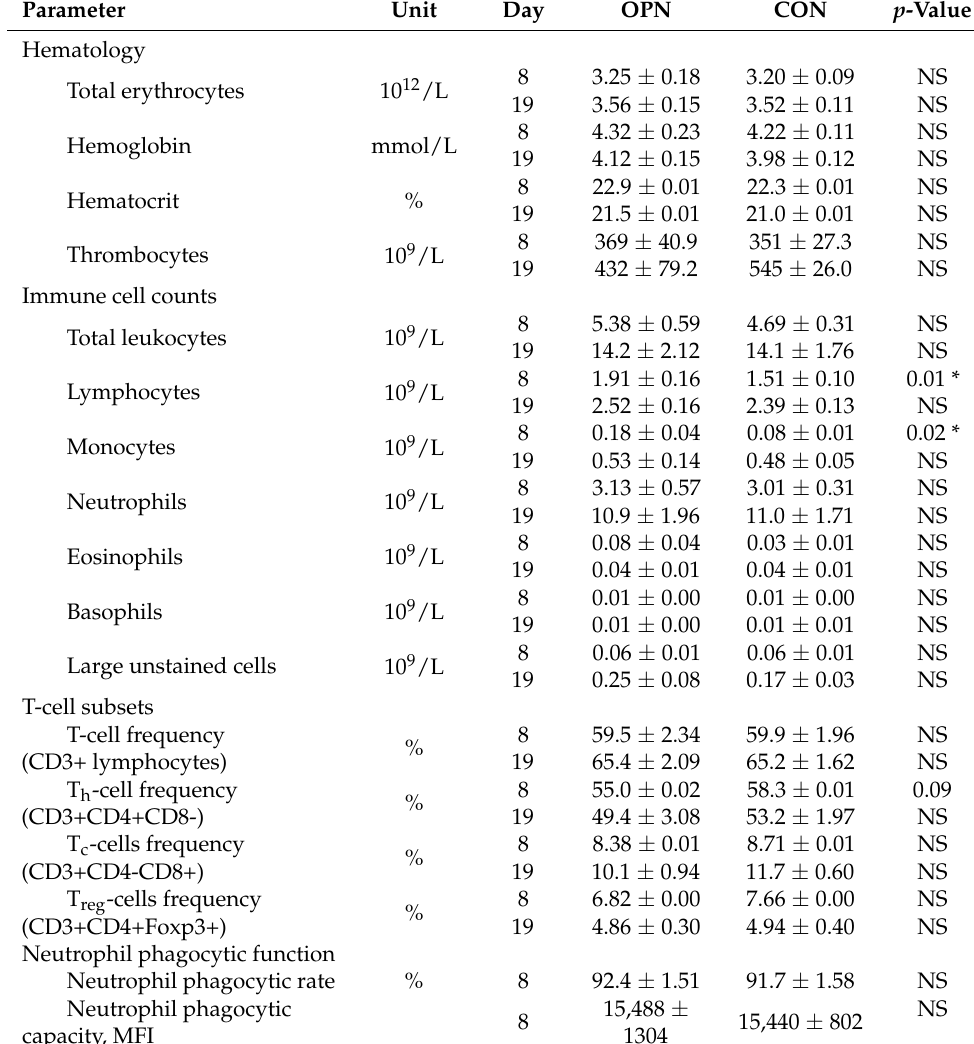
Table 3. Hematological and systemic immunity parameters of preterm pigs on Days 8 and 19. The pigs received a bovine milk diet (CON, n = 12-18) or the milk diet supplemented with OPN (OPN, n =